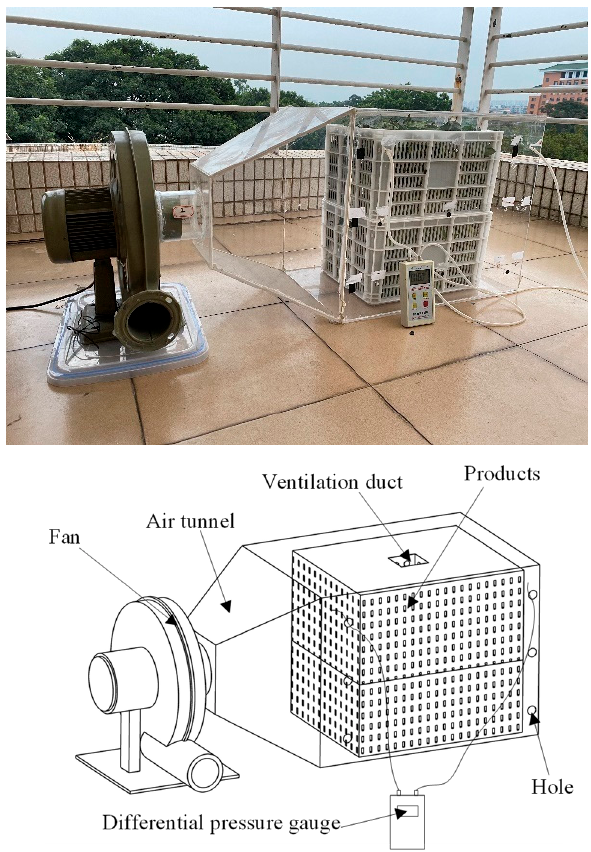
Figure 3. Device used to measure the ventilation resistance.